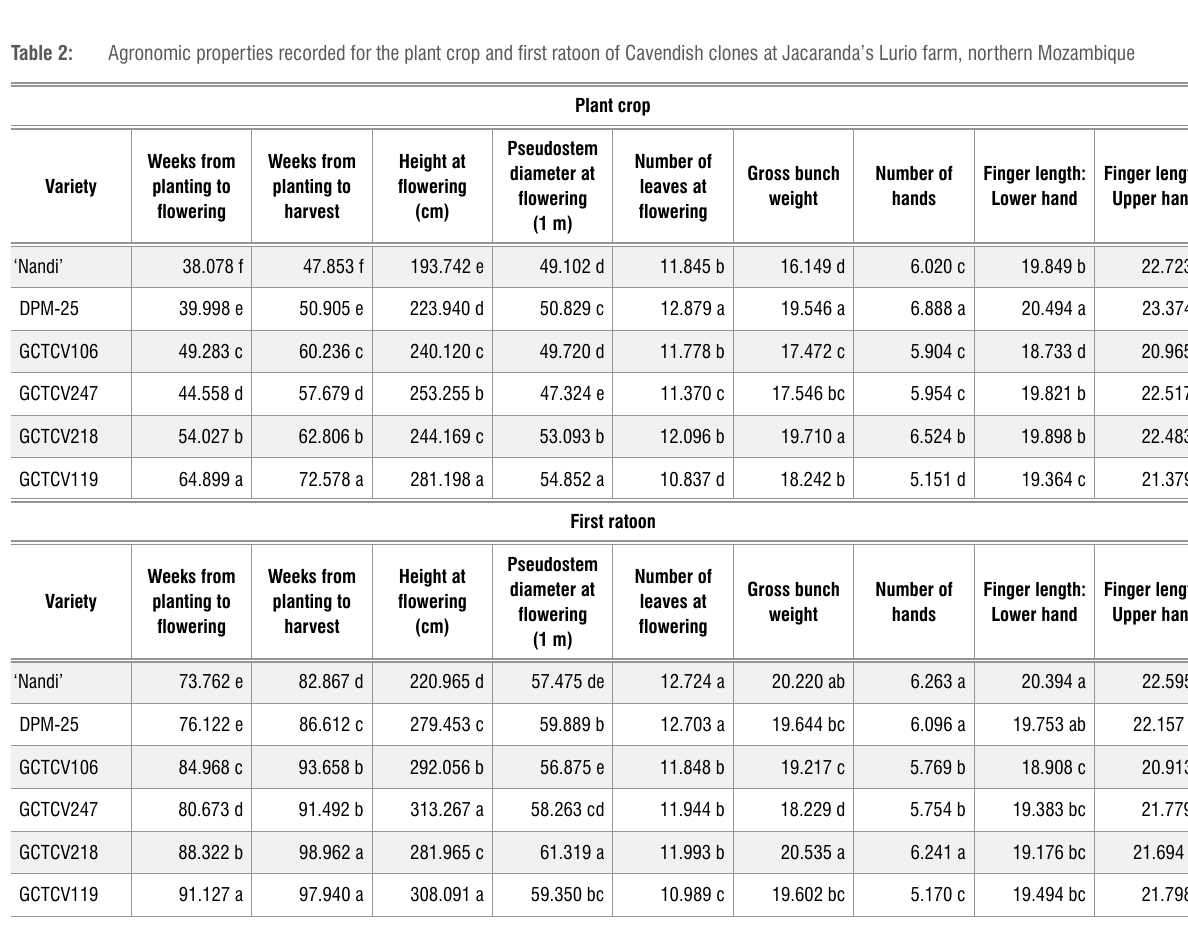
Figure 6: Field evaluation of Cavendish banana somaclones for resistance to Fusarium wilt, caused by Fusarium oxysporum f. sp. cubense TR4, over two seasons. The figures at the top represent the average disease rating over two seasons, and the figures at the bottom represent the area under the disease progress curve. The figures on the left represent the disease development in the plant crop, and those on the right show disease development in the ratoon